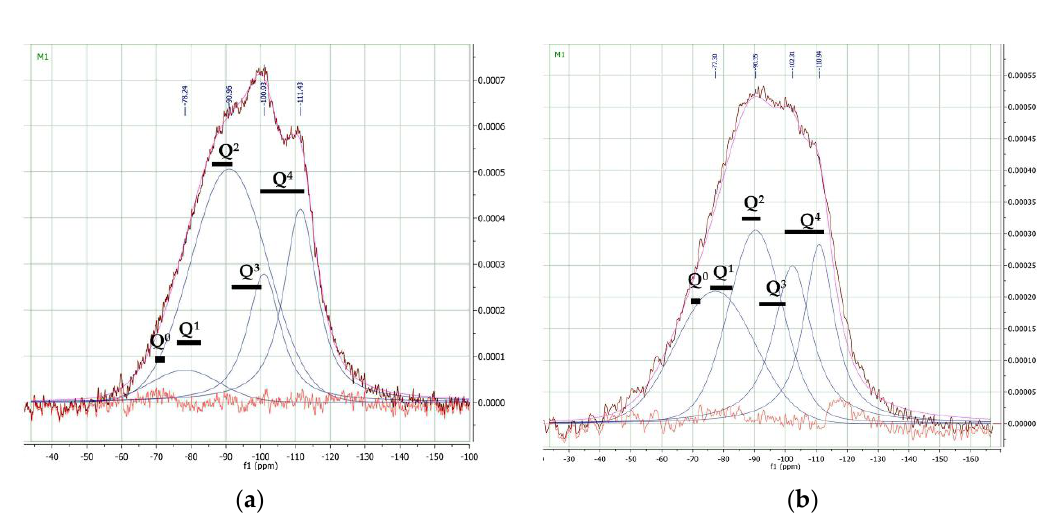
Figure 4. 29 Si MAS spectra of dried waterglass samples and deconvolution with Q n attribution, MAS spinning frequency: 8 kHz; resonance frequency: 99.4 MHz; ( a ) hardening with AlPO 4 , 20,000 scans; ( b ) hardening with BPO 4 , 12416 scans.